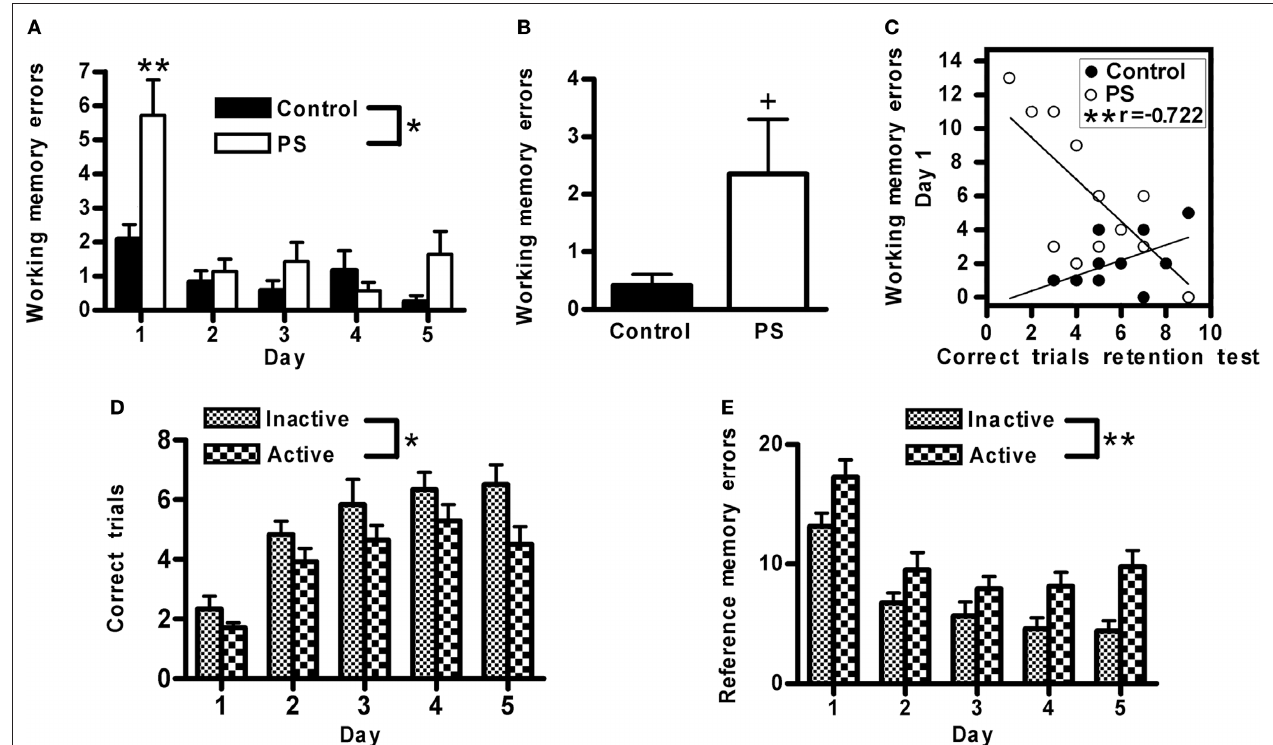
Figure 5 | Spatial/visual discrimination. (A) Prenatally stressed (PS) male rats made more working memory errors during training on this